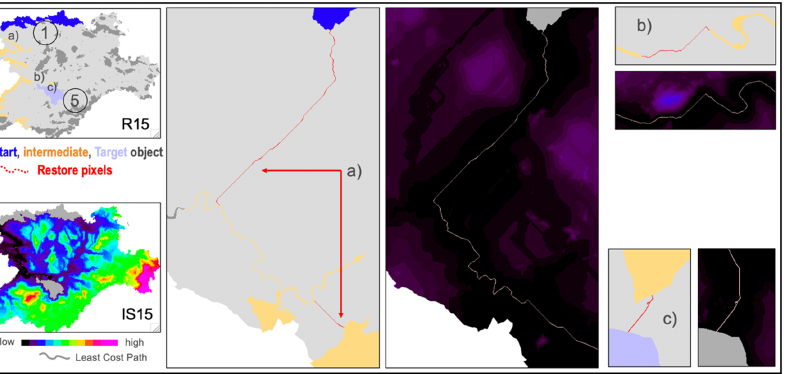
Figure 6. Zoom-in on restoration (R15) and cost map (IS15) for restoration pathway of the Natura2000 scenario. Sections ( a ), ( b ), ( c ) show different pathways to connect the largest (1) with the fifth largest (5) network object in the R15 scenario.